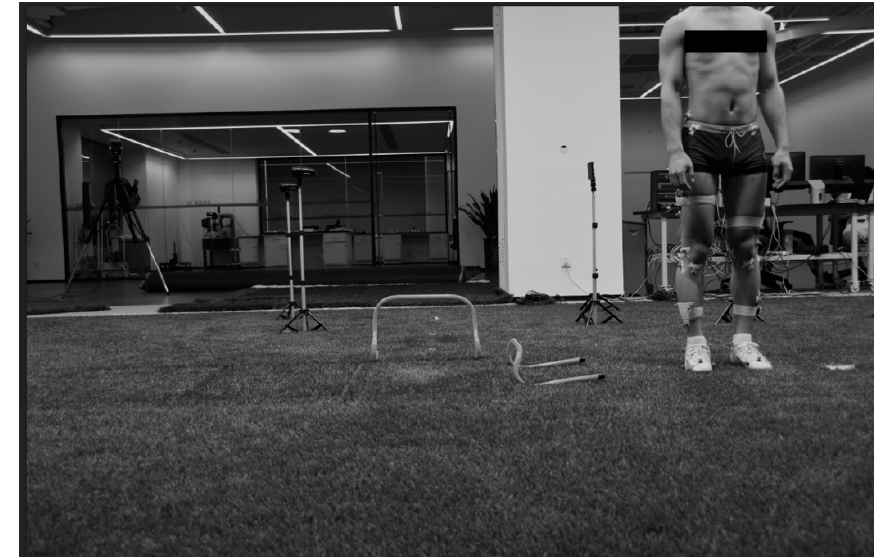
Figure 2. Experimental setup.